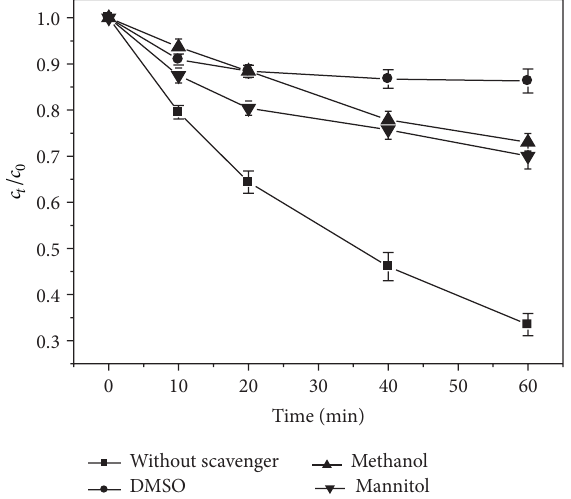
Figure 9: Effect of radical scavenging agents on ultrasonic degrada- tion of fuchsin basic (initial dye concentration = 10 𝜇 mol L −1 , ultra- sonic power = 400 W, ultrasonic frequency = 25 kHz, temperature = 22 ∘ C, and pH =